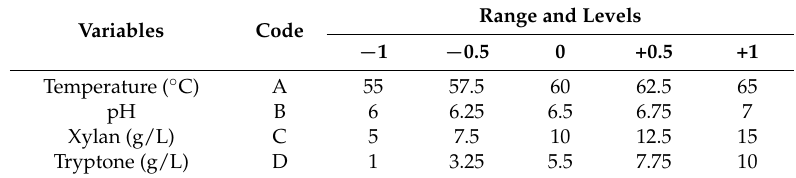
Table 1. Experimental range, level, and coded representation of independent variables for the CCD design.